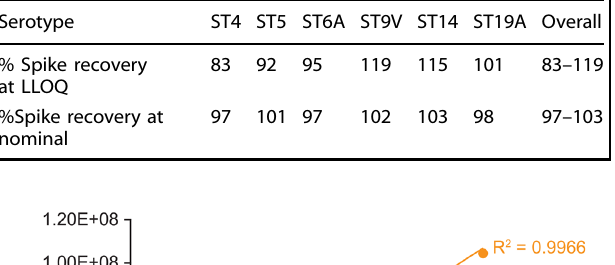
Table 5. Analysis of four PCV serotypes in PCV24 vaccine by